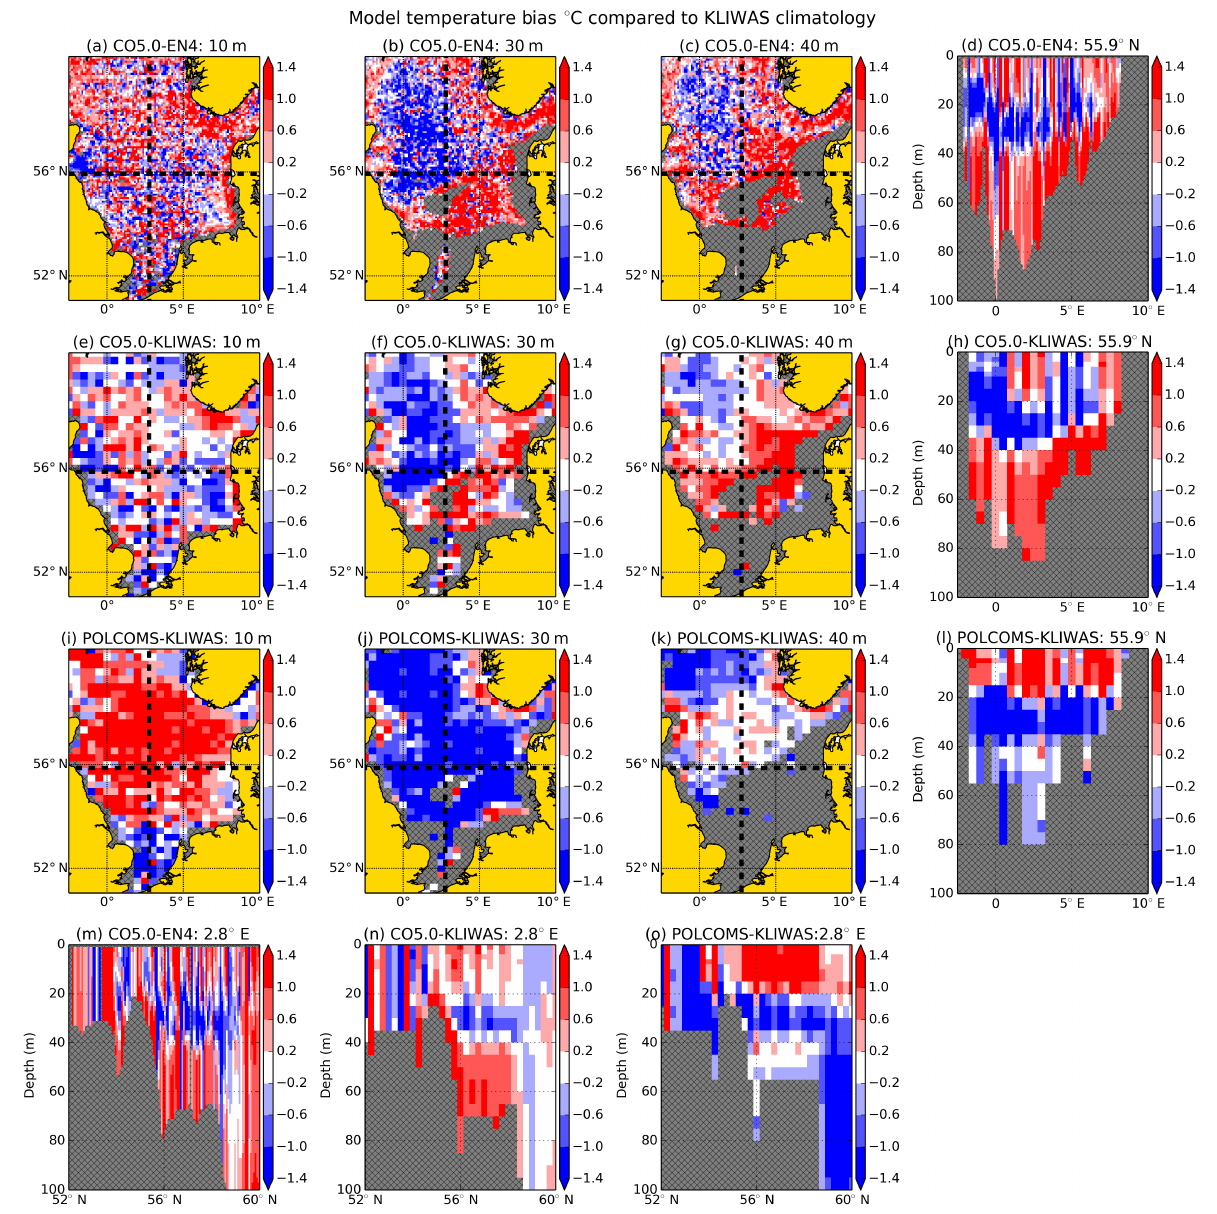
Figure 10. North Sea temperature bias compared to EN4 and the KLIWAS climatology for summer (JJA). Panels (a) – (d) compare CO5 and EN4 at 10, 30 and 40m and along a transect at 56 ◦ N. Panels (e) – (h) compare CO5 and KLIWAS climatology at 10, 30 and 40m and along a transect at 56 ◦ N. Panels (e) – (h) compare POLCOMS and KLIWAS climatology at 10, 30 and 40m and along a transect at 56 ◦ N. Panels (m) – (o) are transects through depth for each case along longitude 2.8 ◦ E. Table 6. Net transports across NOOS